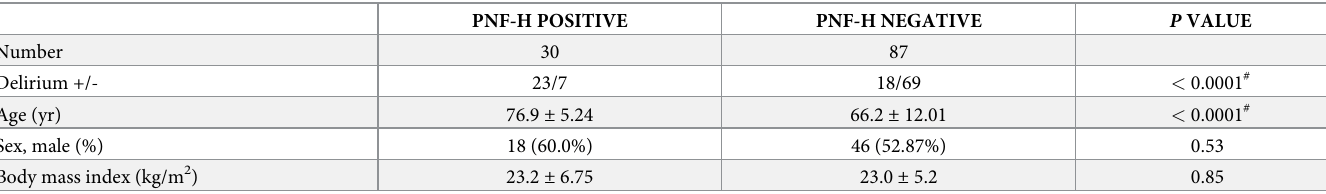
Table 1. Characteristics of the study population.